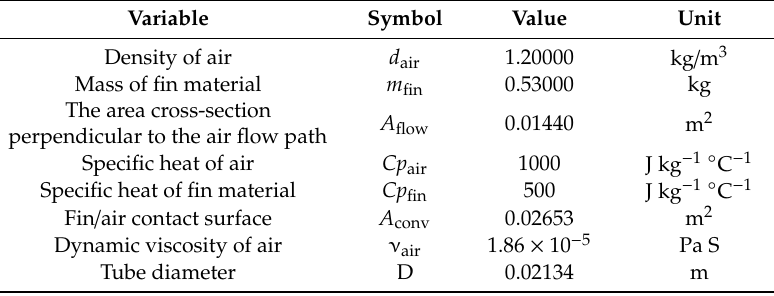
Table 3. The heat convection constants used in this study.